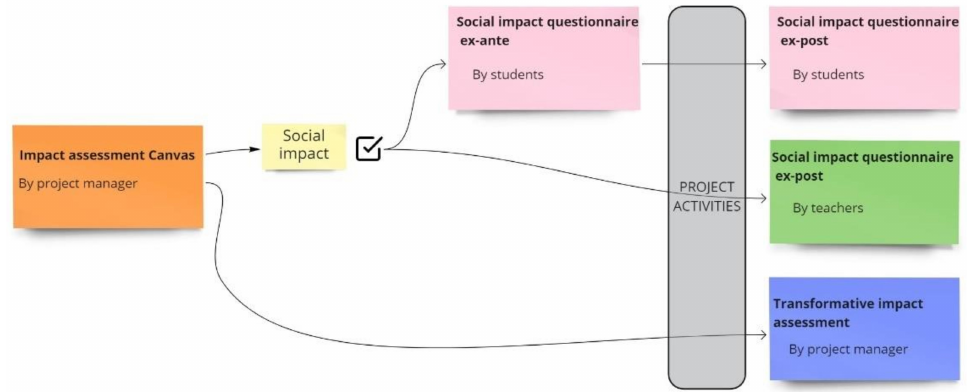
Figure 3. Flowchart visualizing the materials and methods for assessing impact and transformative potential of the Norwegian citizen science pilot “Air quality measurements in high